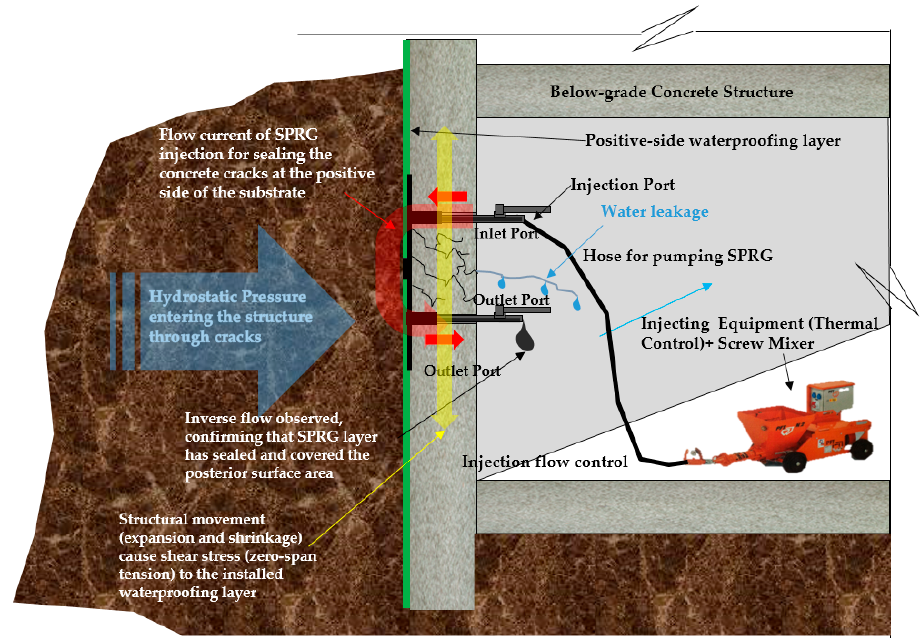
Figure 1. Common Synthetic polymerized rubber gel injection in a below-grade concrete structure.